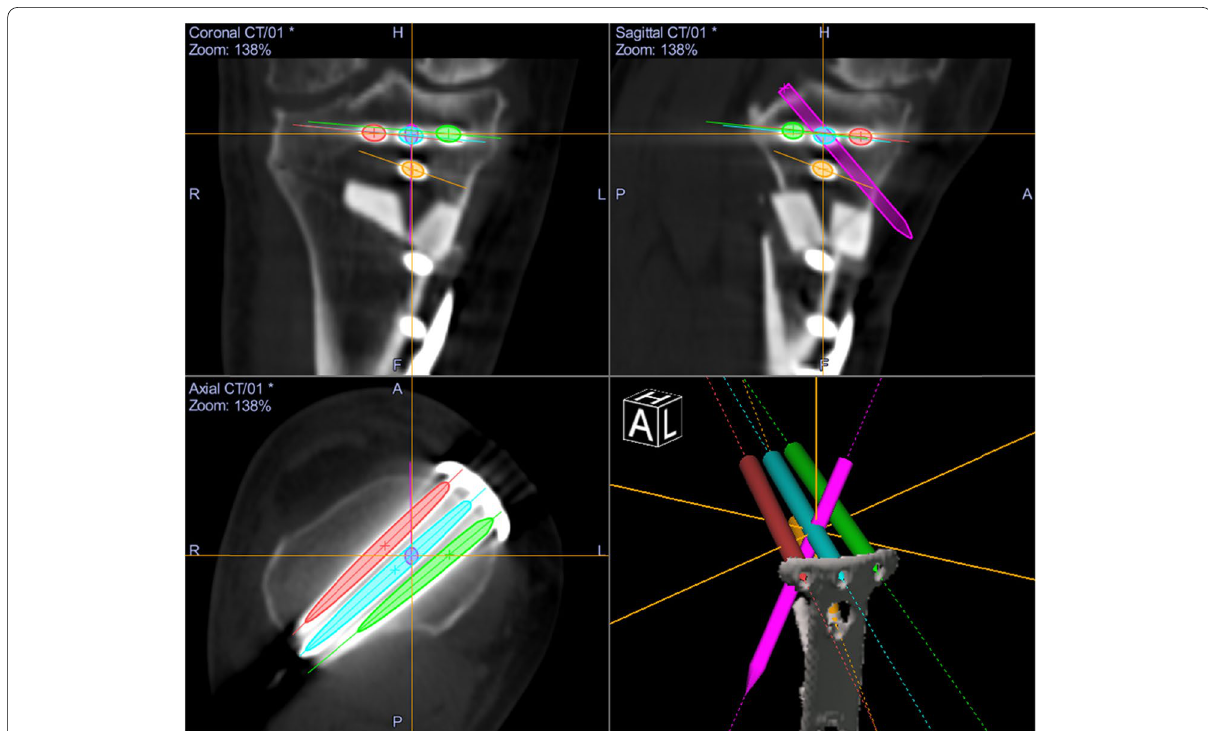
Fig. 4 Each tibial tunnel was created in such a way that the number of screws interfering with the tibial tunnel was minimized. When the number of interfering screws was the same, the tibial tunnel positioning where the screw could be inserted the longest was chosen. In this case, the B screw interfered with the tibial tunnel, which was made on the anteromedial tibial